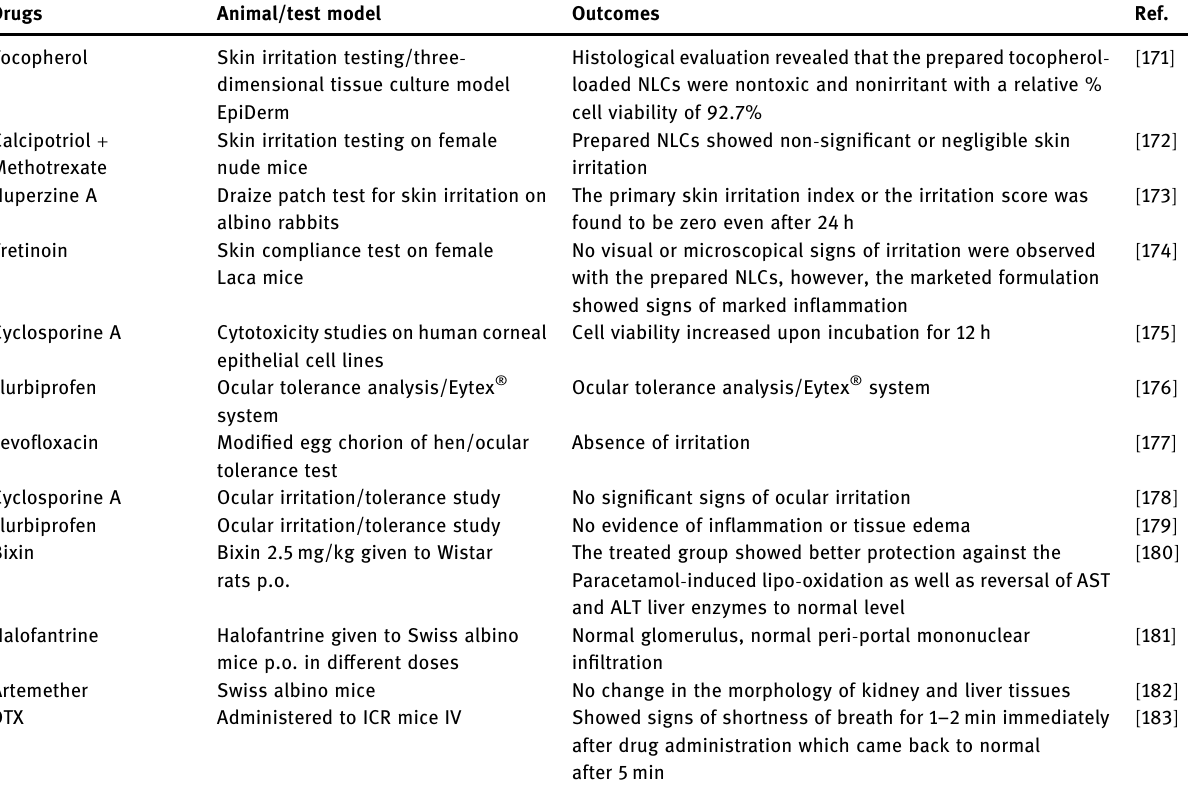
Table 5: Various drug - loaded NLCs tested using animal models ( ex vivo and in vivo studies )